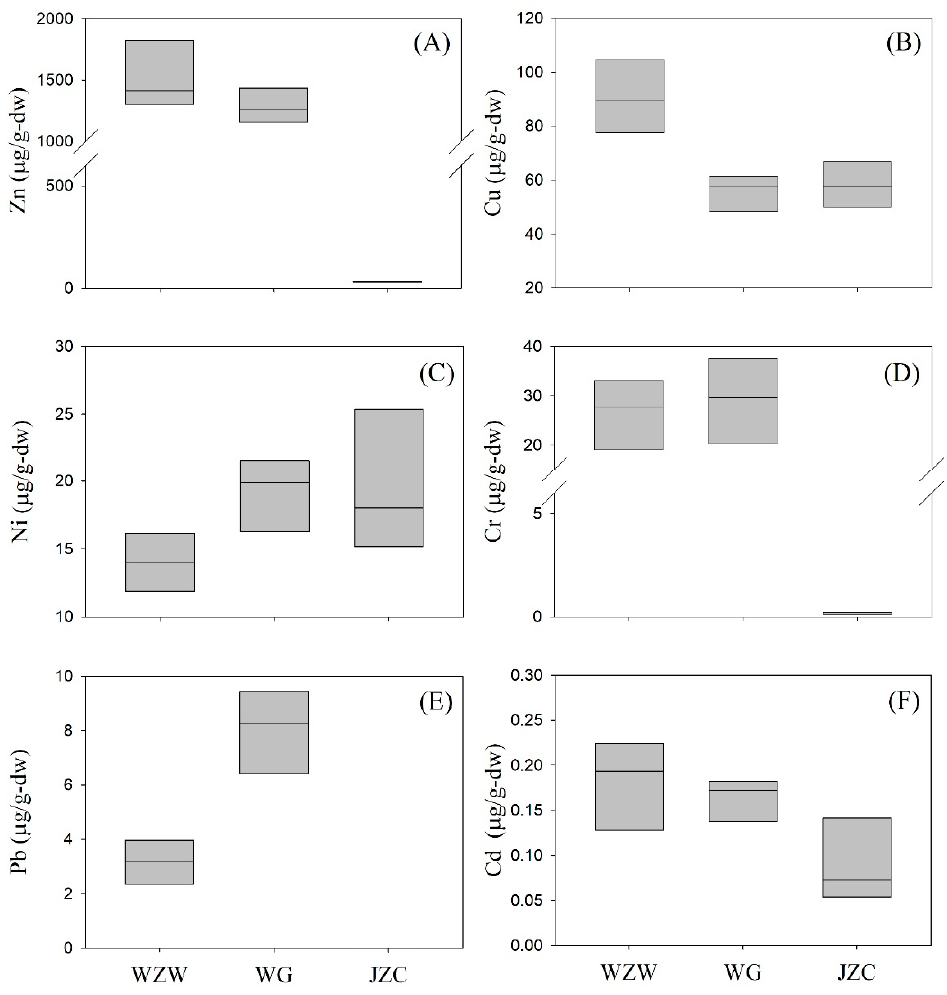
Figure 3. Boxplots showing the mean metallic burdens of ( A ) Zn, ( B ) Cu, ( C ) Ni, ( D ) Cr, ( E ) Pb, ( F )